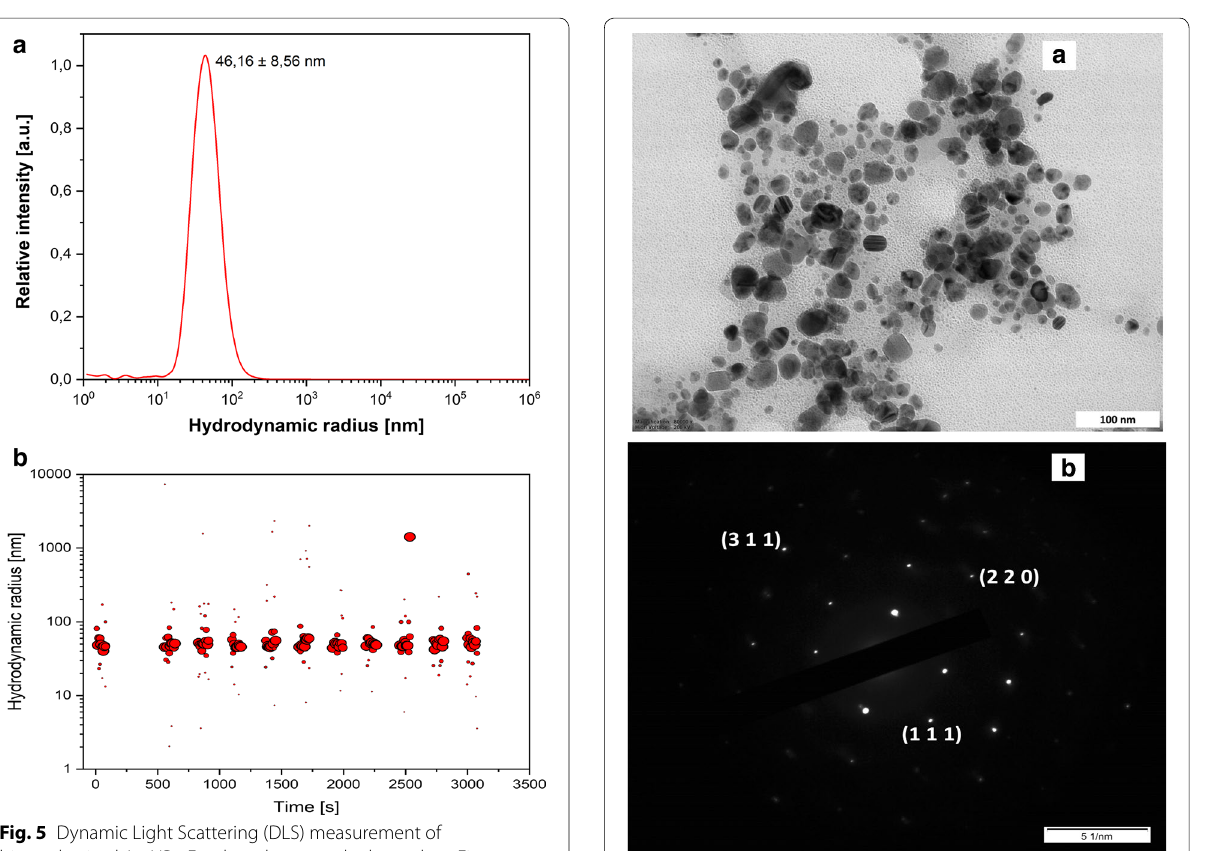
Fig. 6 TEM images ( a ), SAED pattern ( b ) of Ag NPs obtained from A. annua extract. d-spacing values are 2.35, 1.45 and 1.23 Å for (1 1 1), (2 2 0) and (3 1 1) planes, respectively ( b ). For the others, see the legends to Fig.